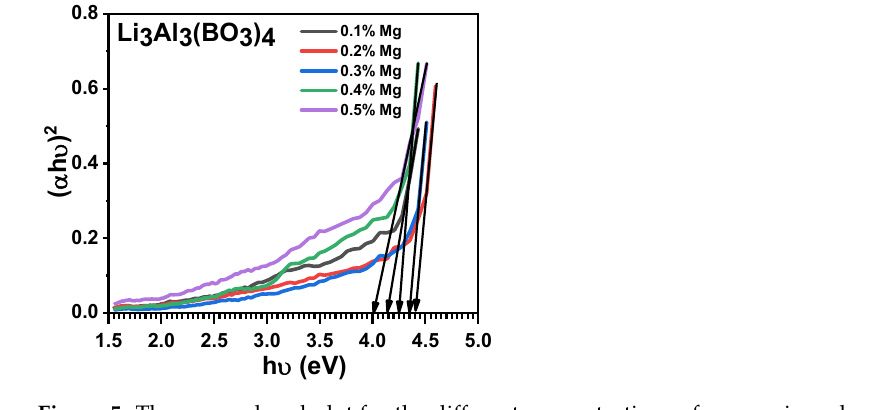
Figure 6. Thermal gravimetric analysis plots of undoped samples and some percentage composi ‐ tions of Mg ‐ doped lithium aluminium borate samples. 3.5. Thermoluminescence Semiconductor materials undergo a stimulated process known as thermolumines ‐ cence (TL) after the absorption of energy from ionizing radiation [35]. TL was used to